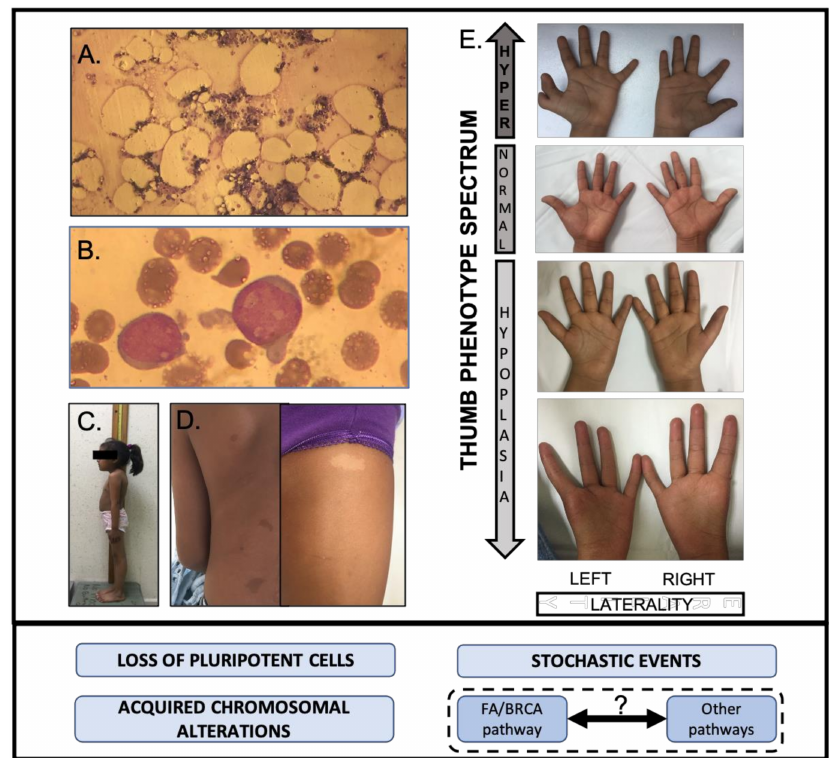
Figure 7. Deficit of the FA / BRCA pathway impacts the Fanconi anemia phenotype. ( A ) Bone marrow failure results from bone marrow attrition due to loss of hematopoietic progenitors. ( B ) Acute myeloblastic leukemia frequently has acquired chromosomal aberrations. ( C ) Somatometric features: short stature and microcephaly are thought to express an early loss of pluripotent cells during development. ( D ) Pigmentation: A hypothesis is that caf é au lait and hypochromic macules could be subjacent to acquired chromosomal alterations in skin cells. ( E ) Thumb abnormality spectrum. Stochastic events are credited for the high variability found in malformative phenotypes of patients with FA, while the interaction of the FA / BRCA pathway with other developmental pathways remains to be